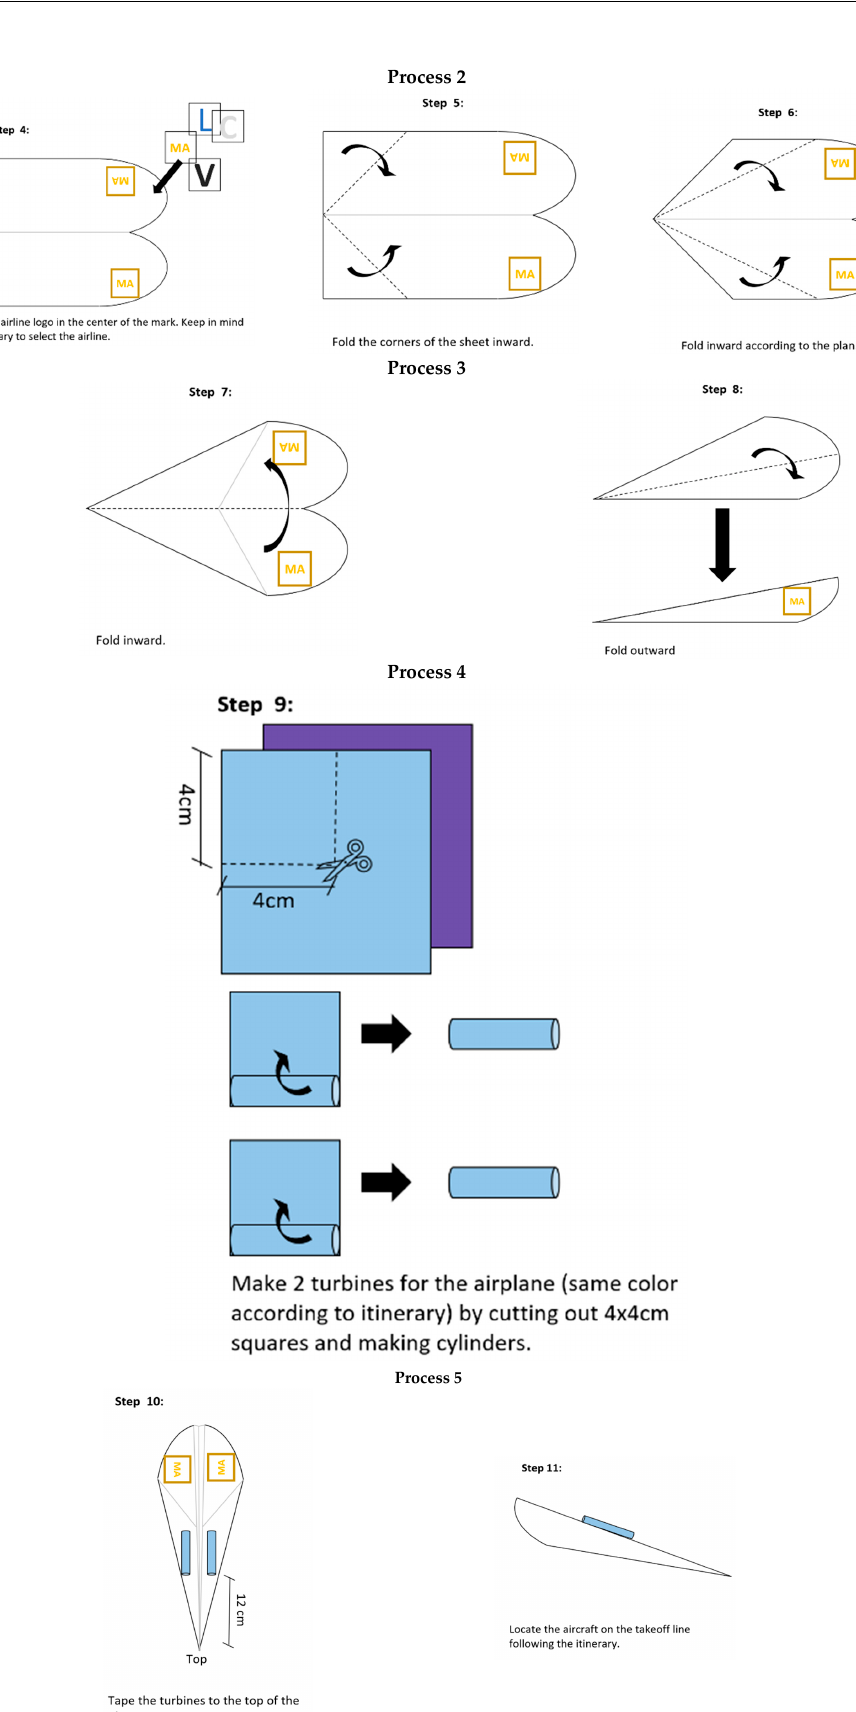
Figure A2. Paper plane specific drawings.